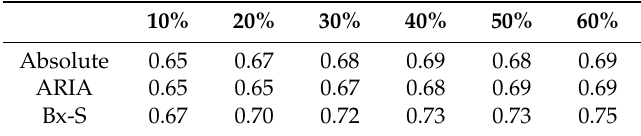
Table 2. The effect on ROC AUC of varying the % landslide area threshold required for an aggregate pixel to be defined as ‘landslide’ for 200 m × 220 m aggregate